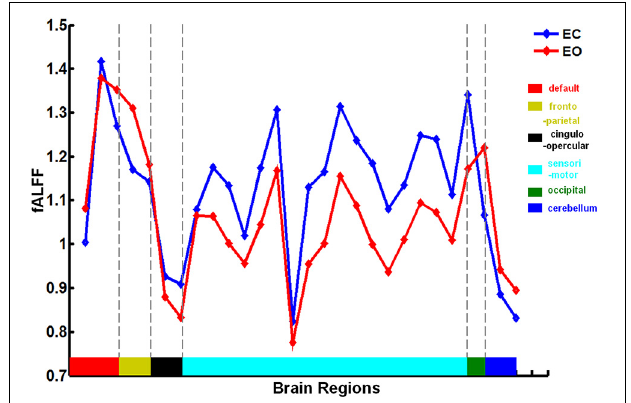
FIGURE 2 | Brain regions involved in the discriminative pattern corresponding to | Z | > 1 . 96. The details of the brain regions and modules are listed in Table